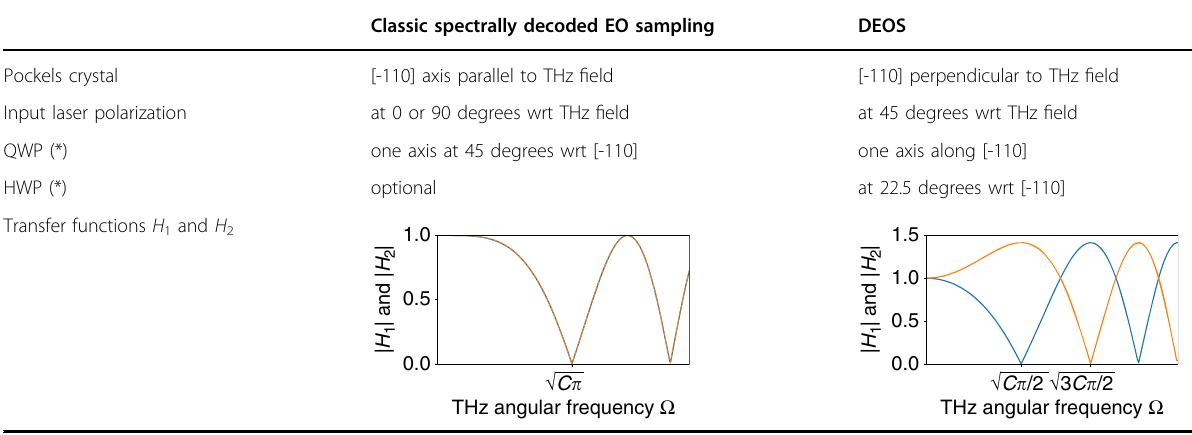
Table 1 Differences in crystal and waveplates orientations between classic spectrally decoded EO sampling (Fig. 1) and the new phase diversity (DEOS) system (Fig.